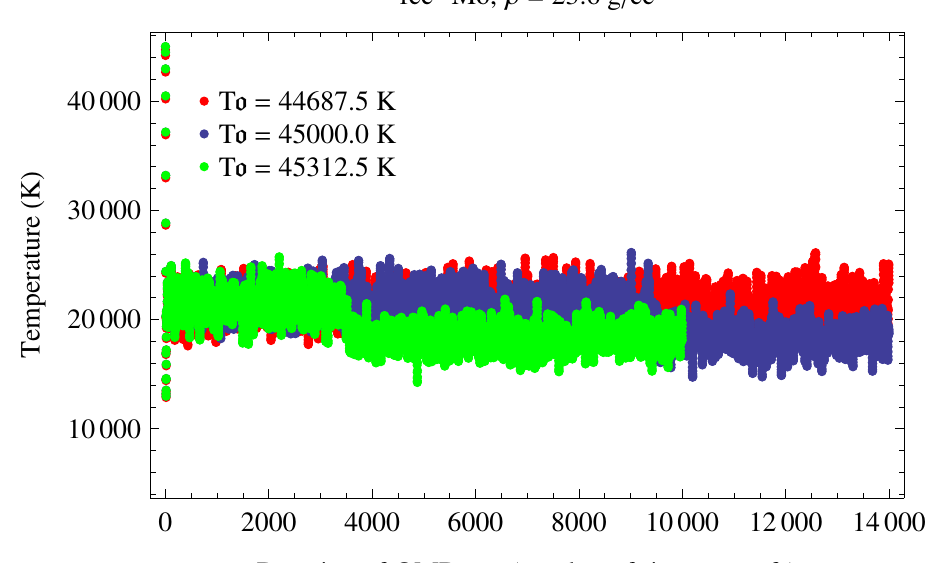
Figure 8. Time evolution of temperature in three QMD runs with initial temperatures (T 0 s) separated by 312.5 K. The middle run is the melting run, during which T decreases from ∼ 22,000 K for the superheated state to ∼ 18,300 K for the liquid at the corresponding melting point.